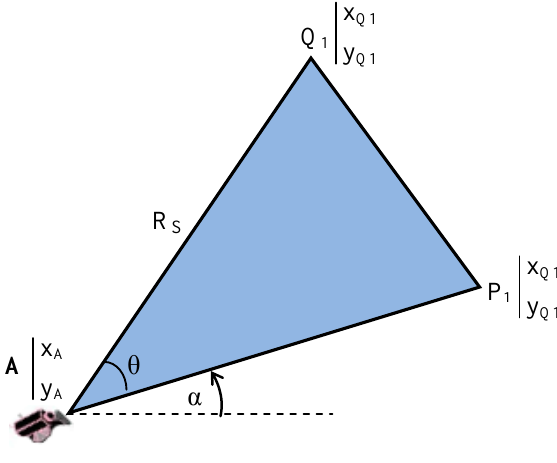
Figure 1. FoV of a multimedia